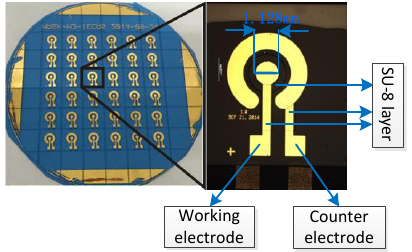
Figure 1. The pattern and structure under a 12.5× optical microscope of the Au microelectrodes.